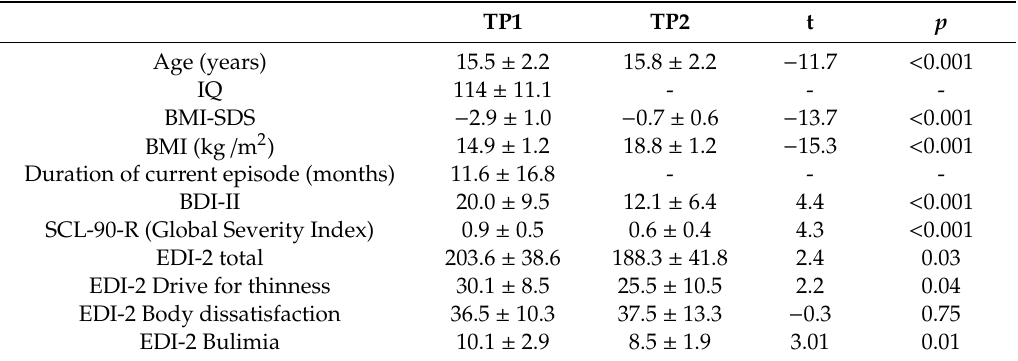
Table 1. Demographics and clinical characteristics of the longitudinal anorexia nervosa (AN) sample (N = 22).